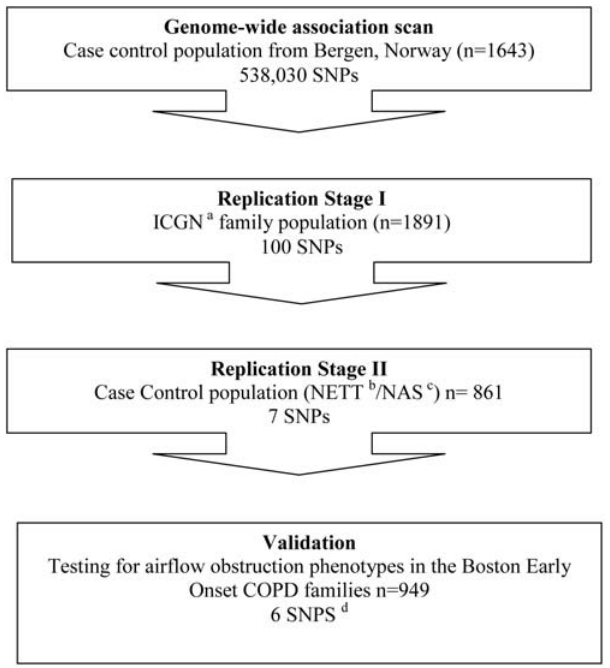
Figure 1. Study design. SNP: Single Nucleotide Polymorphism. a ICGN: International COPD Genetics Network families. b NETT: National Emphysema Treatment Trial. c NAS: Normative aging study. d One of the SNPs genotyped in NETT/NAS population (rs735243) was not success- fully genotyped in the BEOCOPD population.